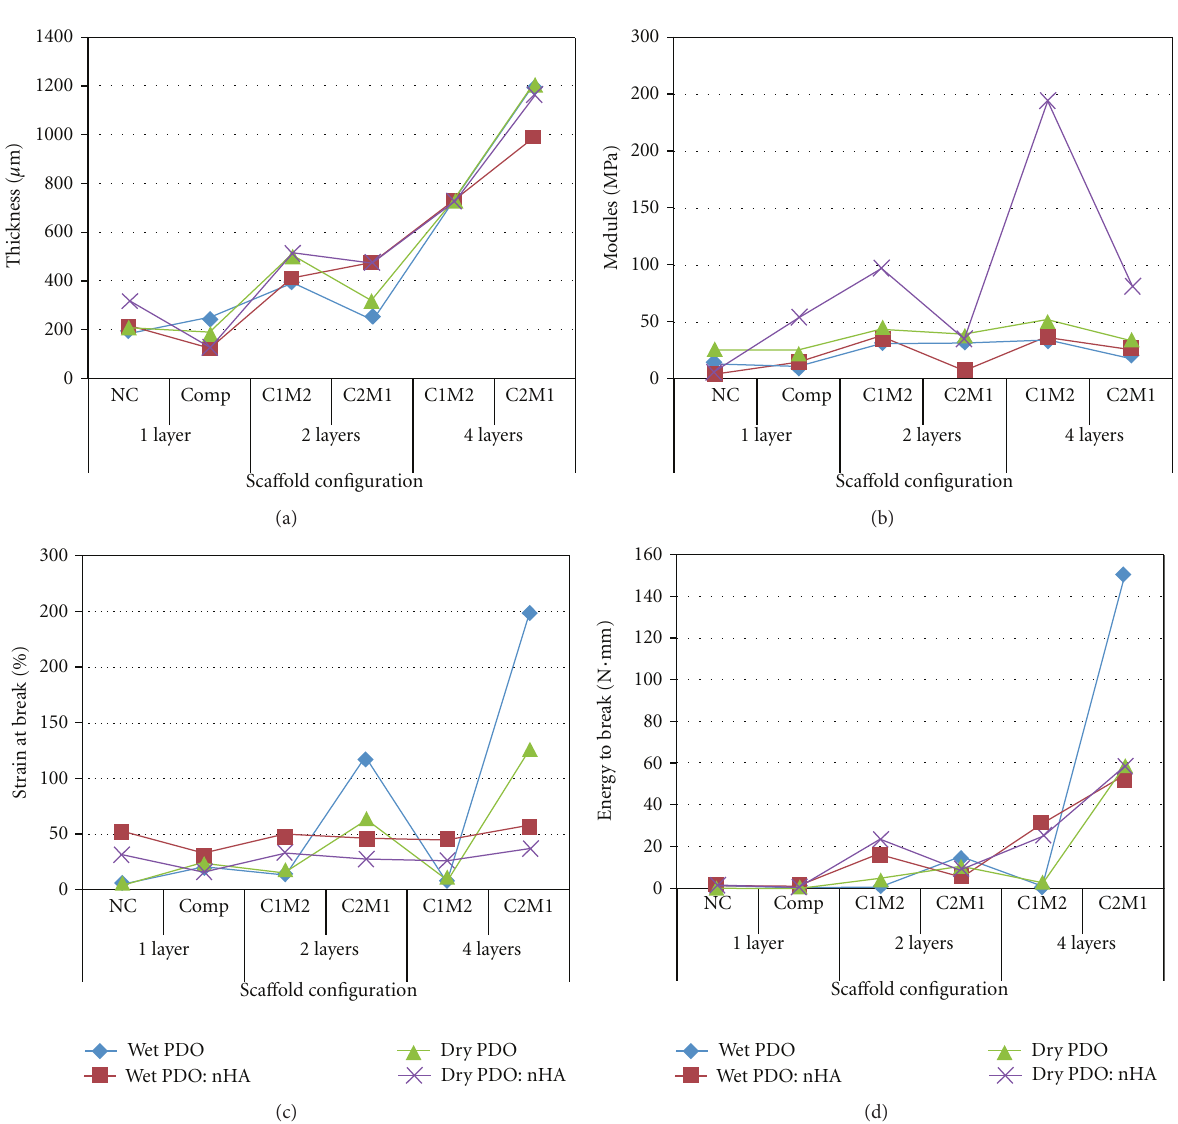
F4:Comparisonof(a)thickness,(b)stiffness(Young’smodulus),(c)strainatbreak,and(d)energytobreakinmultilayeredmineralized electrospun PDO and PDO:nHA scaffolds under dry and hydrated testing conditions. e effects of compression welding the scaffolds are also shown. In scaffolds containing more than 1-layer, compression welding of the scaffolds was done before SBF treatment (C1M2) or the scaffolds were mineralized separately and then compressed at the end of 2 weeks (C2M1). Non-compressed (NC), compressed